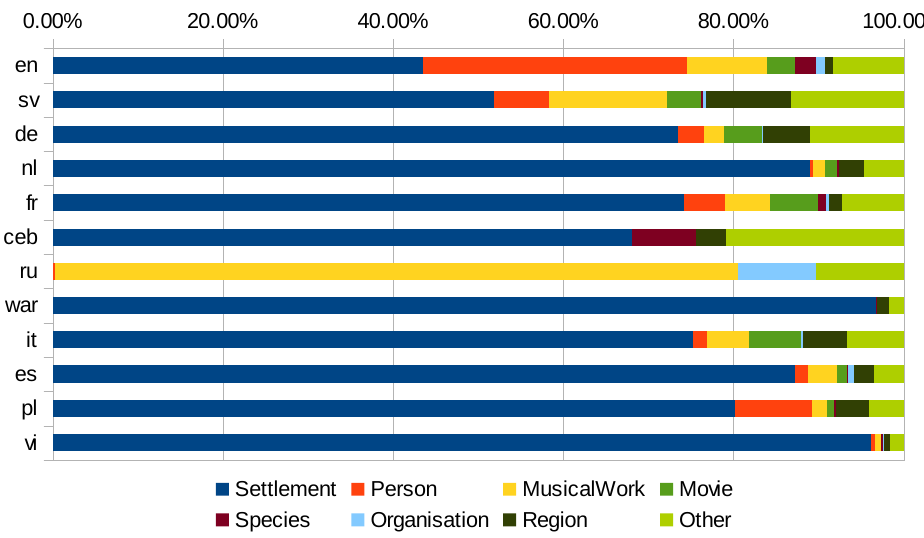
Figure 7. Distribution of subject types in the different language